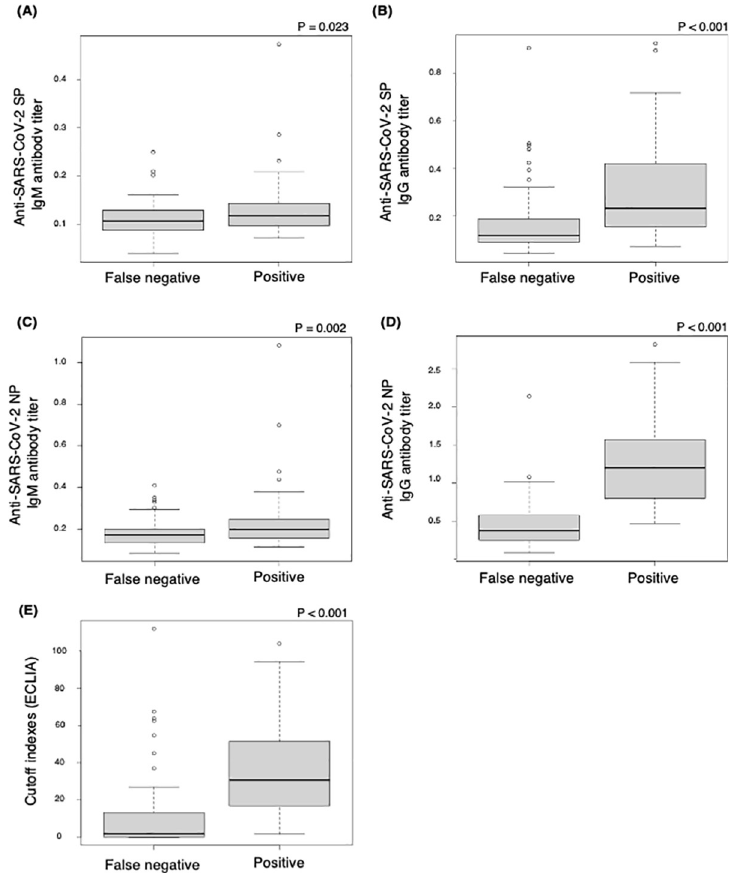
Fig 3. Comparison of anti-SARS-CoV-2 antibody titers between samples with false-negative and those with positive LFA results. Anti-SARS-CoV-2 SP IgM (A) and IgG (B) and anti-SARS-CoV-2 NP IgM (C) and IgG (D) antibody titers in blood samples collected from 143 cruise ship crew members who had positive first SARS-CoV-2 genetic test results were measured using ELISA. Antibody titers were significantly lower in blood samples with false- negative LFA results (n = 74) than in those with positive LFA results (n = 69). The cutoff index in ECLIA was also significantly lower in blood samples with false-negative LFA results than in those with positive LFA results. SP, spike protein; NP, nucleocapsid protein; ELISA, enzyme-linked immunosorbent assay; LFA, lateral flow immunochromatographic assay; ECLIA, electrochemiluminescence immunoassay.